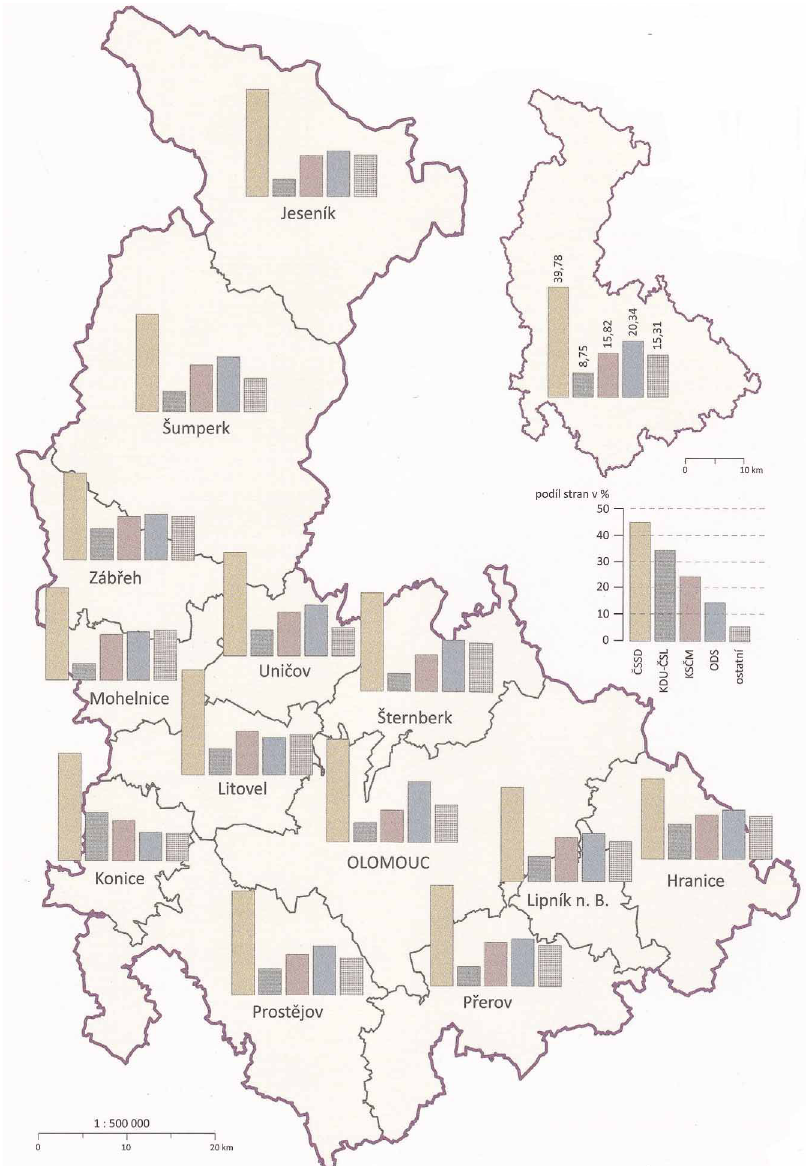
Fig. 6. Diagram map with the results of five political parties